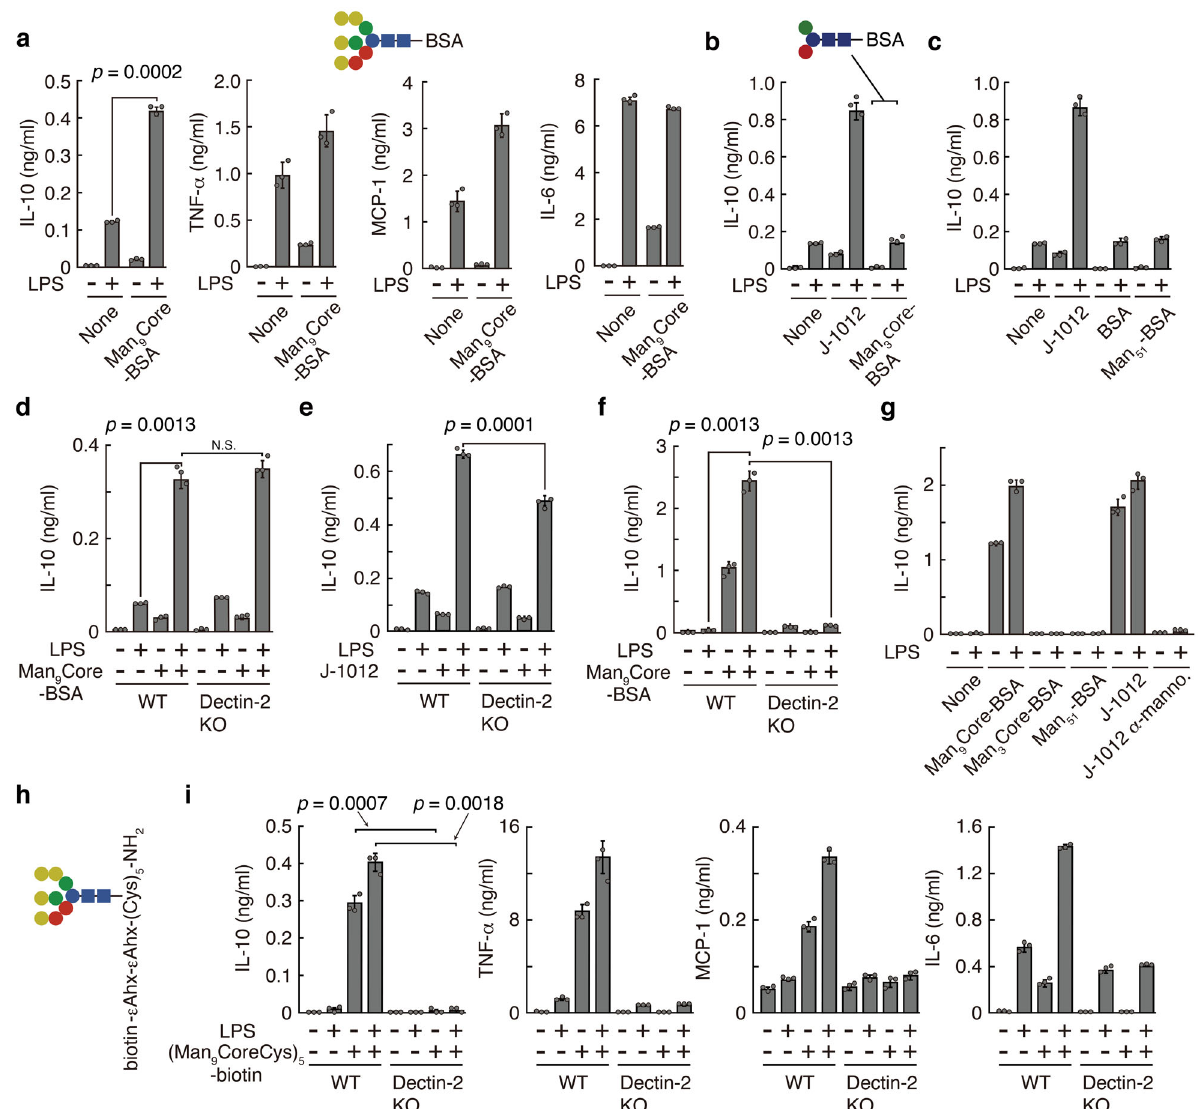
Fig. 3 Augmentation of IL-10 production by mannose core in vitro. a – e Cytokine production by rpM ϕ from WT( a – c ) and Dectin-2KO ( d , e ) mice after stimulation with Man 9 Core-BSA, Man 3 Core-BSA, Man 51 -BSA (bound more than 51 mannose monomers), and J-1012 N-glycan, immobilized on plates as in Fig. 2h. Schematic structures of Man 9 Core-BSA and Man 3 Core-BSA are depicted. f IL-10 production by BMDCs from WT and Dectin-2KO mice in response to Man 9 Core-BSA. g IL-10 production by BMDCs from WT mice upon stimulation with Man 9 Core-BSA, Man 3 Core-BSA, Man 51 -BSA, J-1012 N-glycan, and J-1012 N-glycan treated with α -mannosidase. h Schematic structure of (Man 9 CoreCys) 5 -biotin. ε AHX, ε -amino-n-hexanoic acid. i Cytokine production by BMDCs from WT and Dectin-2KO mice upon stimulation with (Man 9 CoreCys) 5 -biotin bound to an avidin-coated plate. These experiments were repeated at least twice, and representative results are shown. Data are expressed as the mean ± SD. p value was determined by unpaired two-tailed Student ’ s t- test. N.S., not signi fi cant ( p >